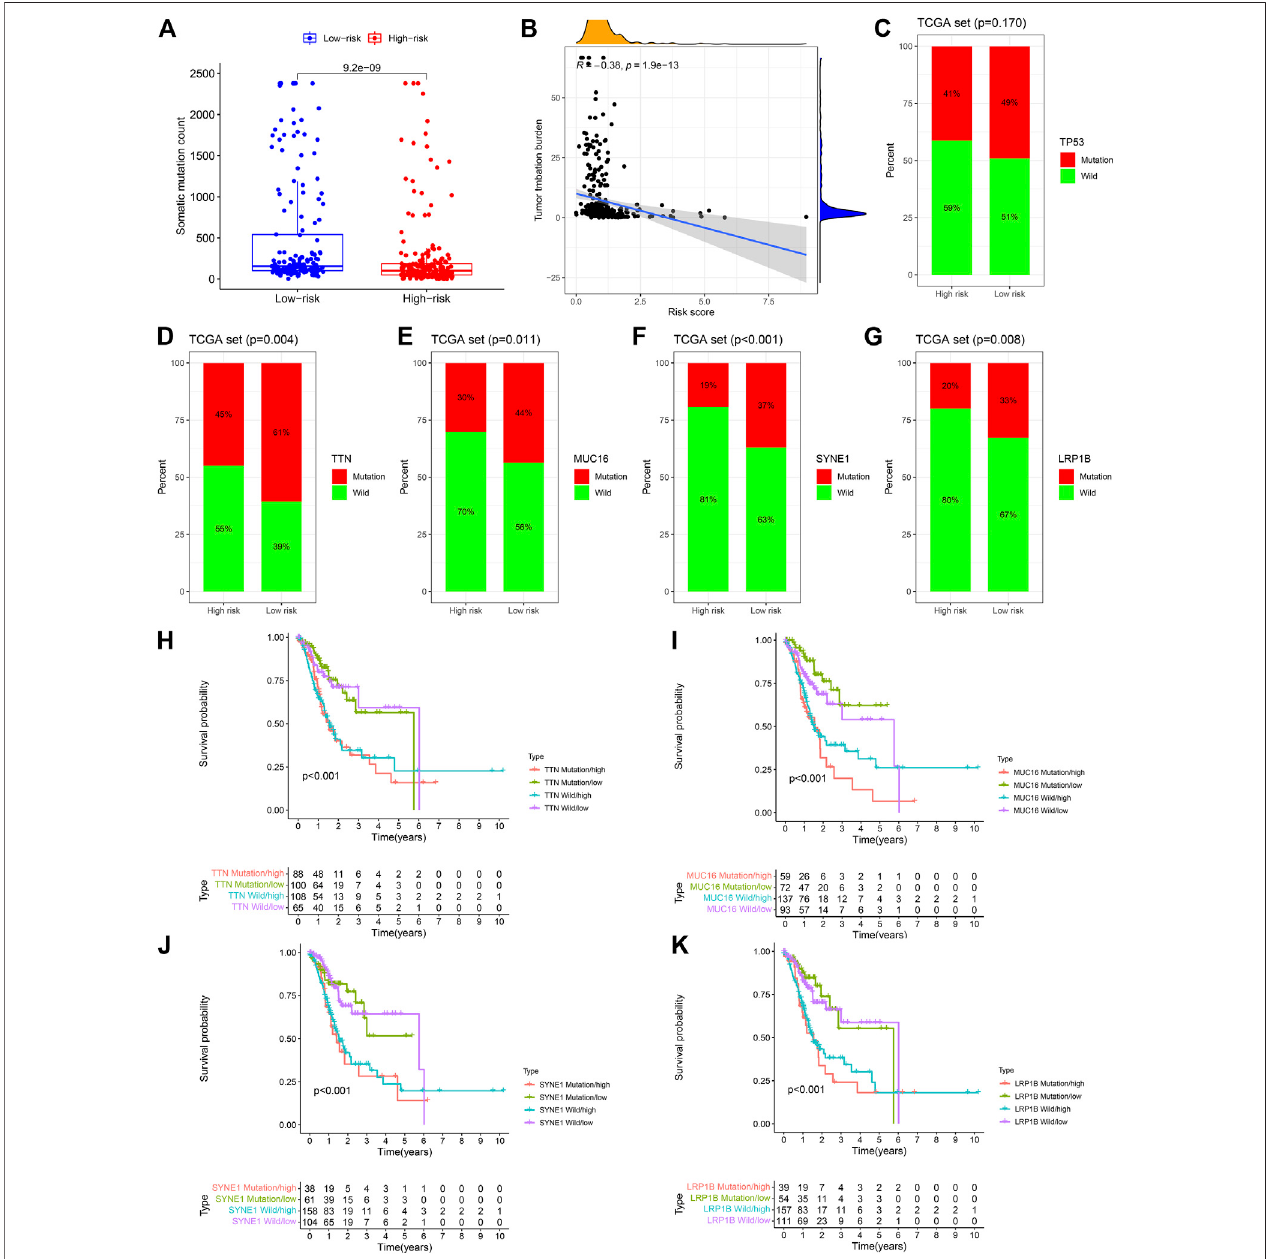
FIGURE 9 | The mutant landscape of the high-risk and low-risk STAD patients. (A) Comparative analysis of mutation events between the high-risk and low-risk subsets. (B) Mutation events are negatively correlated with RS. (C – G) Difference analysis of the top 5 mutant genes between the low-risk and high-risk subsets. (H – K) Survival analysis based on the risk classi fi cation and mutation status of TTN, MUC16, SYNE1, and LRP1B.